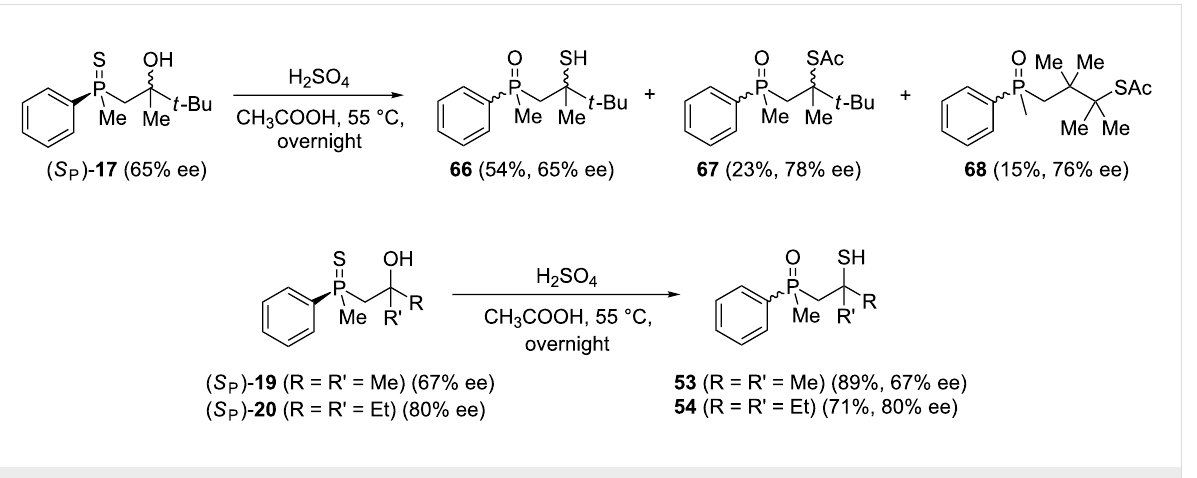
process. What was more striking, the complete racemization of ( S P ) -65 and the extended racemization of ( S P ) -17 occurred under the reaction conditions. This suggested that the rearrange- ment may have proceeded either via two different pathways, or one of the reaction components may have influence the rate of racemization. In the case of ( S P ) -17 , the postulated dissociation of AlCl 3 ⋅ OH may have generated traces of HCl, which may have react with the cyclic intermediate, leading to a pentavalent compound. The latter would have been very susceptible to Berry or turnstile pseudorotation. This, in turn, should have led to a remarkable deterioration of the enantiomeric excess of the product. The same might be postulated for the rearrangement of alkenylphosphine sulfide 65 , which should form a pentavalent intermediate equally